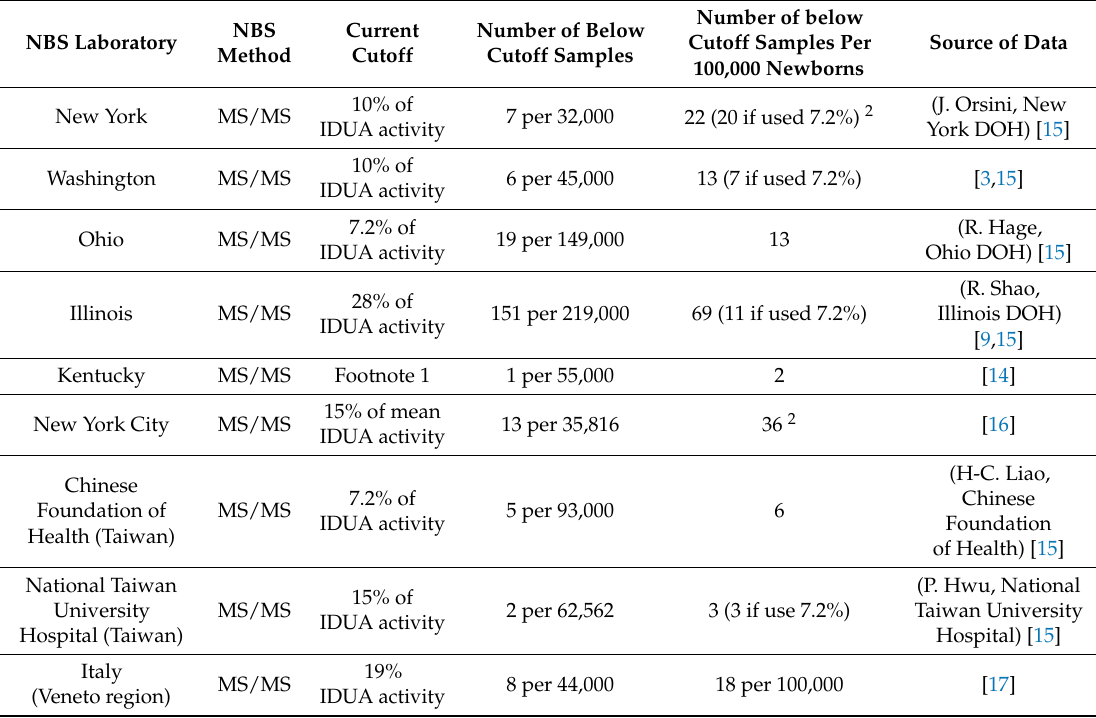
Table 3. NBS laboratory screen positive rates for